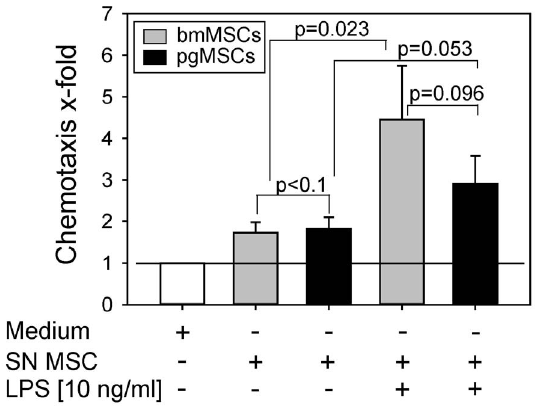
Figure 5. Activated bmMSCs and pgMSCs induced the recruitment of PMNs. A migration assay using a Transwell insert culture system was used to evaluate the migration of PMNs toward medium, MSCs (bmMSCs and pgMSCs, each n=5) supernatant (SN), and supernatant of LPS-stimulated MSCs. Data are presented as median of 5 independent experiments. Spontaneous migration toward control medium was set as 1 (reference value); statistical analysis by ANOVA test; significance was set at the level of P # 0.05.